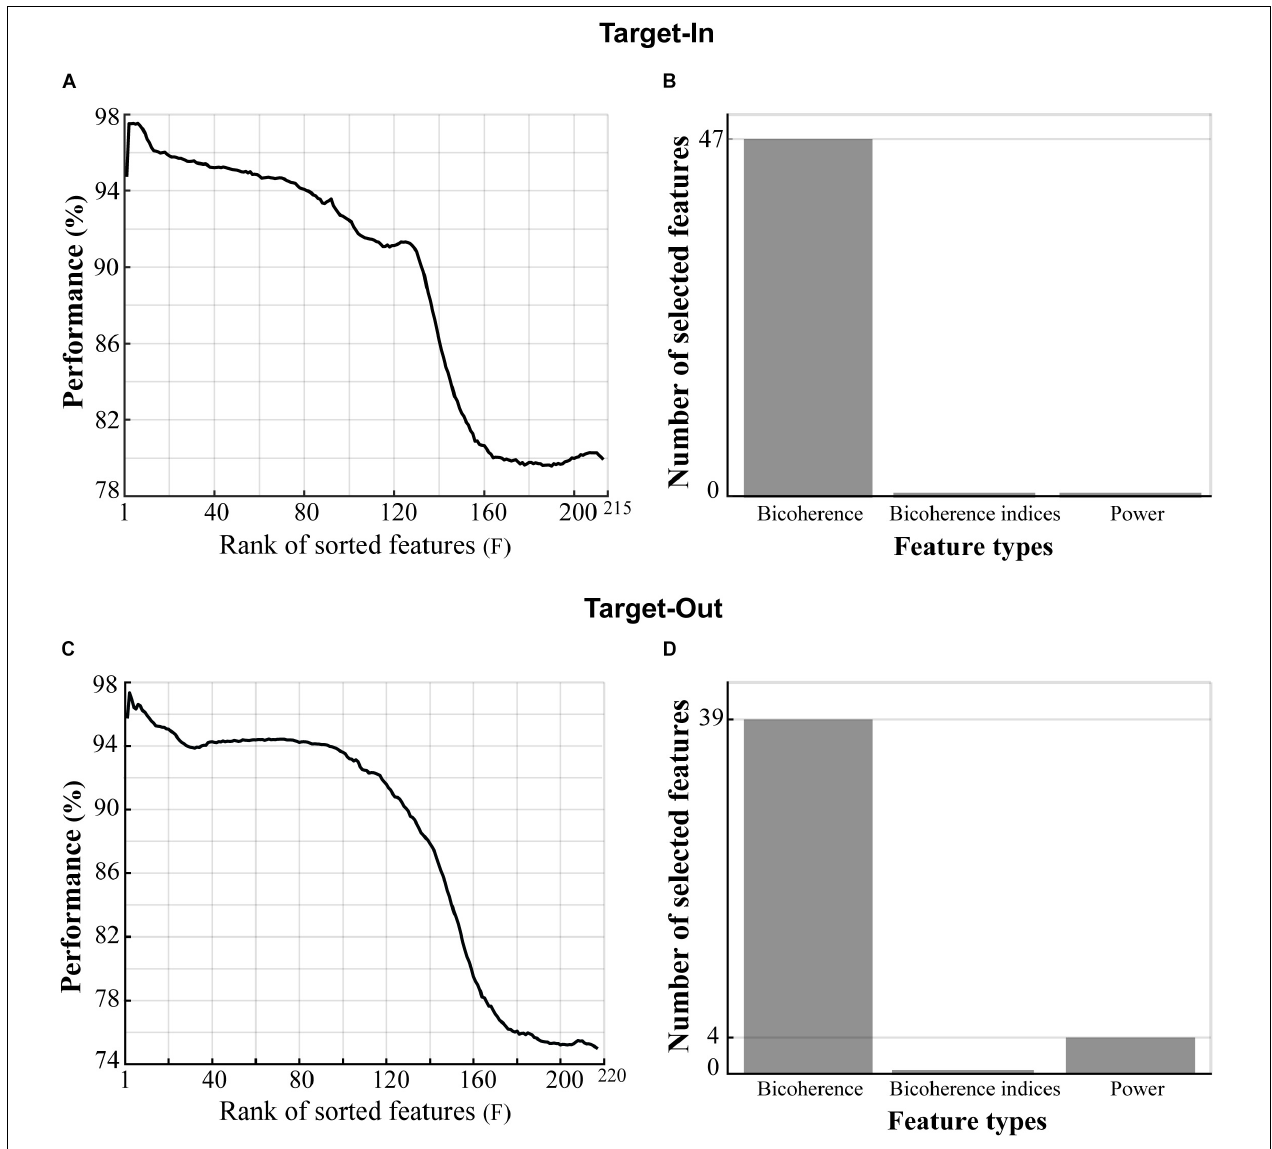
FIGURE 4 | Type of features providing high classification performance in decoding the fast and the slow trials. (A,C) Three types of features (shown on the x -axis of panels B,D ) in the Target-In and the Target-Out conditions, respectively, which were sorted based on the decoding performance in descending order. (B,D) Types of features in panels (A,C) , respectively, which provided classification performance of over 95% in decoding the fast and the slow trials. The selected bicoherence in panels (B,D) lies on the high-gamma frequency band (150–250 Hz, see Figure 5 ). The selected powers in panel (D) lie between 190 and 200